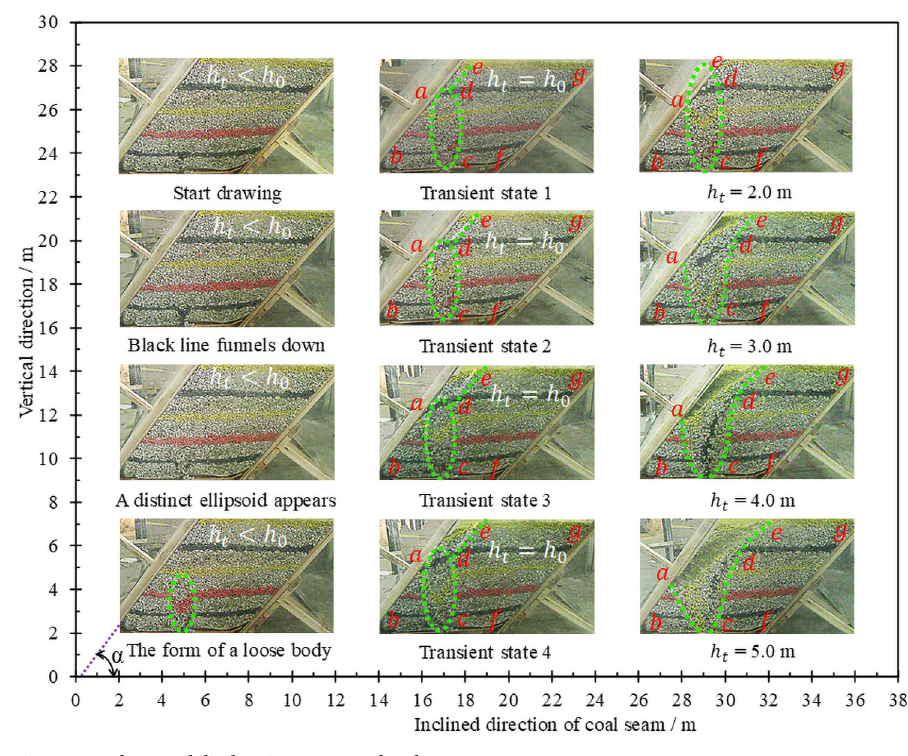
Fig 3. Loose form and discharging process of